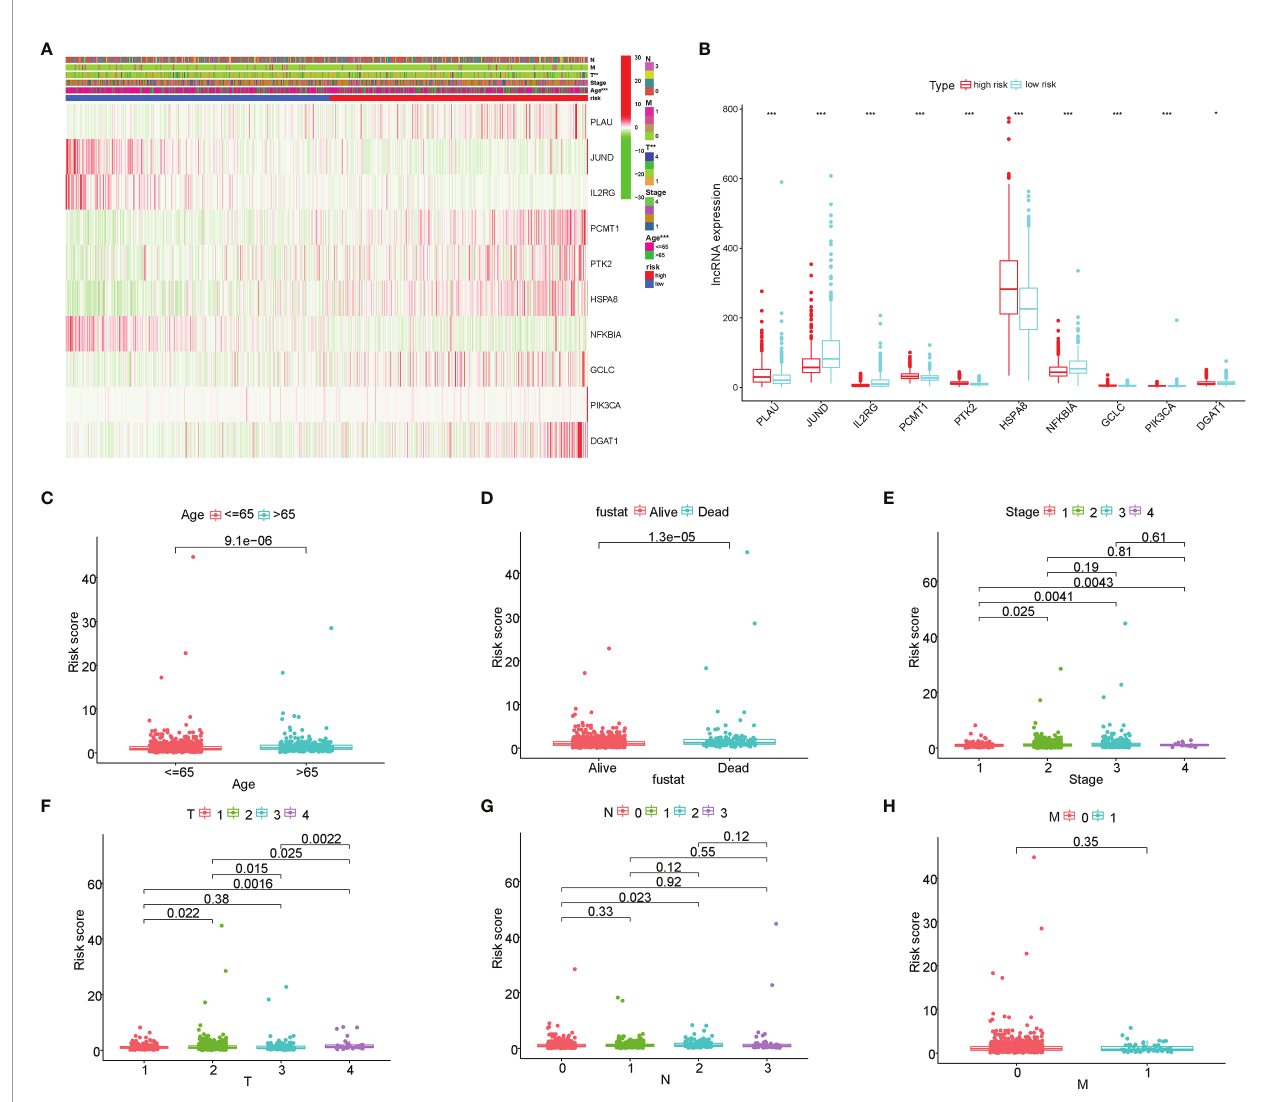
FIGURE 6 | The correlation of the risk score with the clinical characteristics of breast cancer (BC). (A) The heatmap displayed the correlation between the 10 aging- related genes (AGs) and the clinical features of BC. (B) The expression of the 10 AGs is signi fi cantly different between high- and low-risk groups. (C – H) The scatter diagrams veri fi ed that the risk score had different distribution patterns in BC patients with different clinical characteristics, including age, survival status, clinical stage, and TNM staging. *P<0.05; **P<0.01;